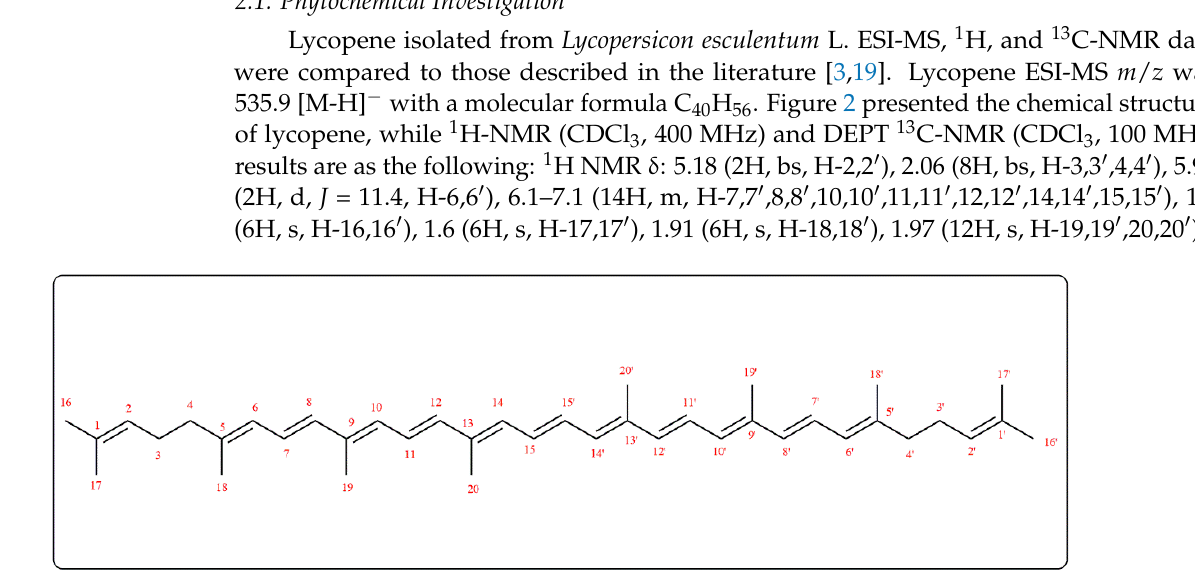
Figure 2. Chemical structure of lycopene.